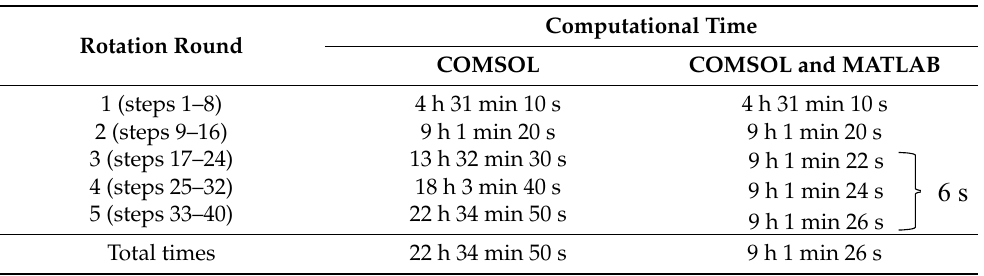
Figure 3. Geometry of household-microwave oven and ready-to-eat sausages at the position angle from 0° to 315° with waveguide (red dotted line). Table 2. Computational time of temperature simulation of COMSOL and COMSOL in combination with MATLAB (COMSOL and MATLAB).